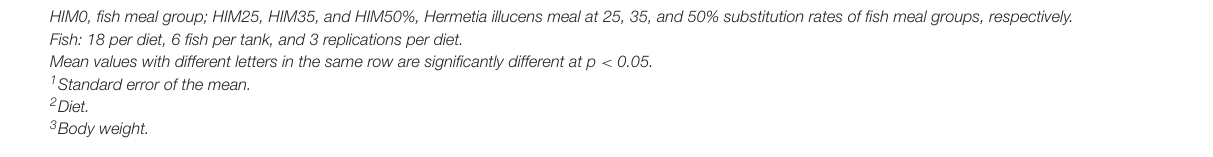
TABLE 9 | Microbial profile (log cfu/g) of the skin, intestine, and muscle of the gilthead sea bream fed with the four exerimental diets. Items